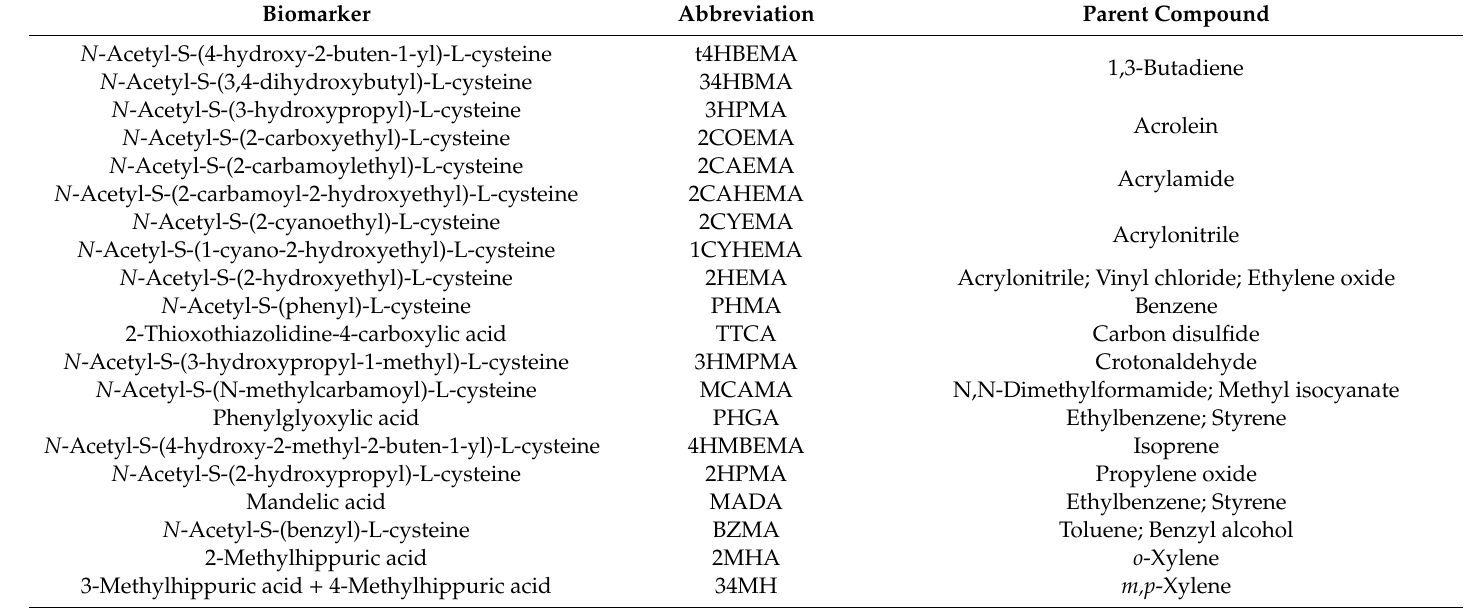
Table 2. Urinary volatile organic compound metabolites (VOCMs) measured for the Population Assessment of Tobacco and Health (PATH) Study Wave 1